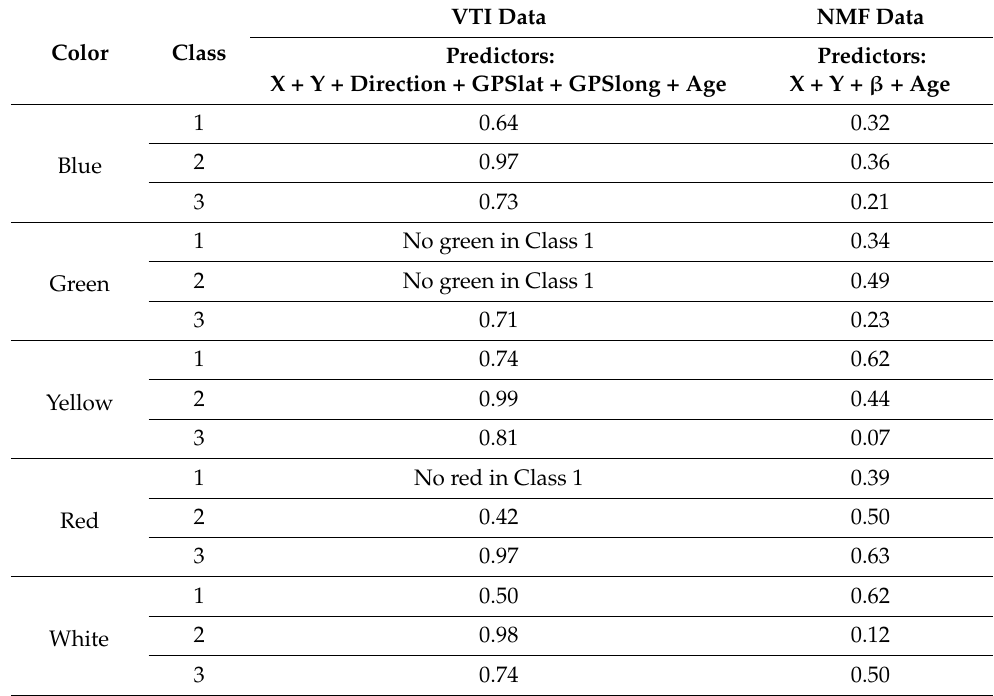
Table 6. R 2 values for each color and class for VTI and NMF data (using logarithmic